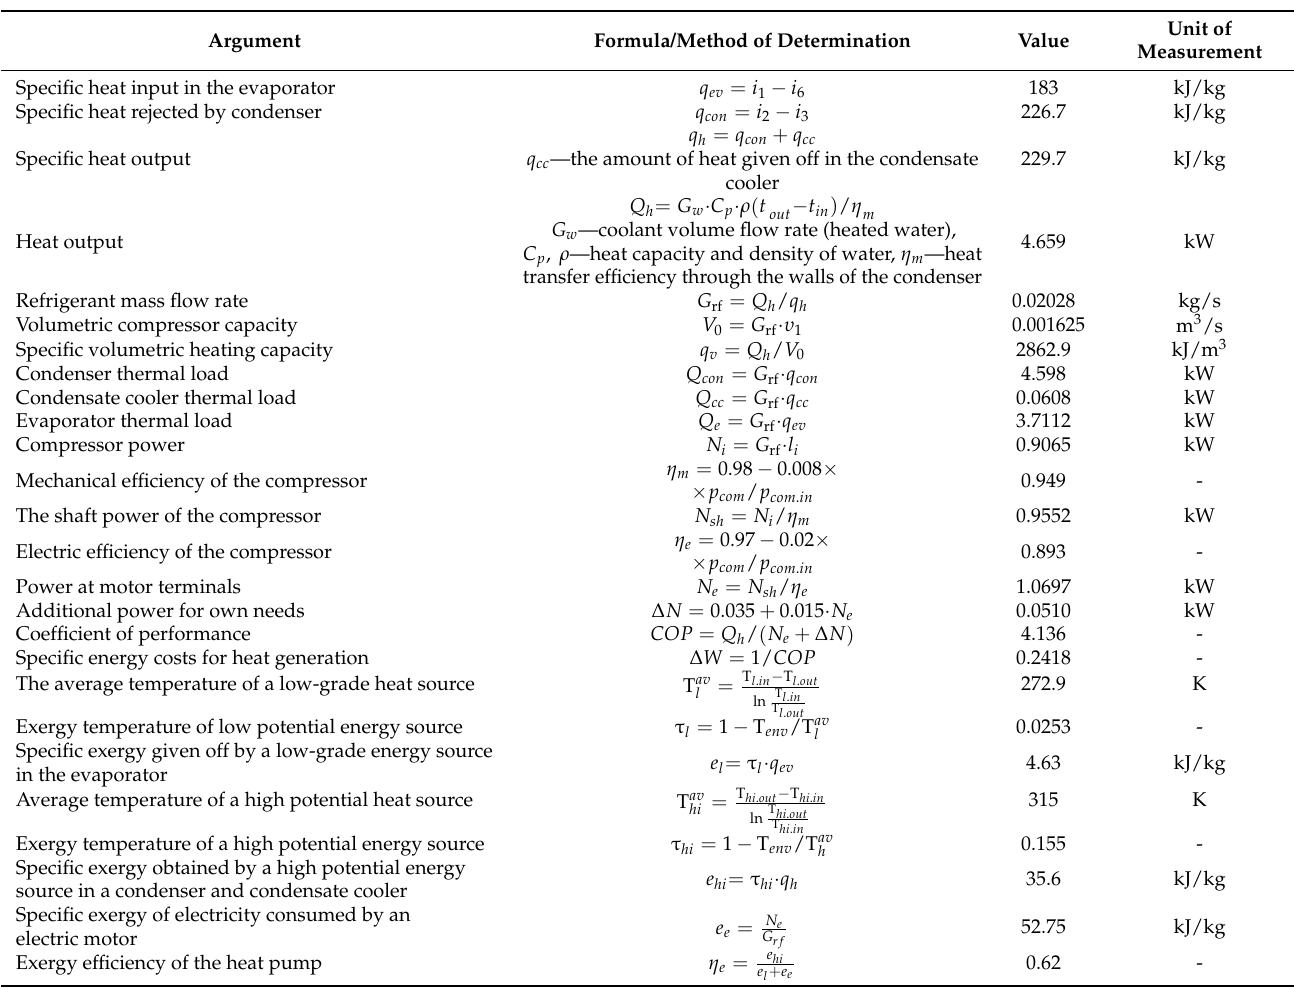
Table 3. Specific values of the heat pump installation.